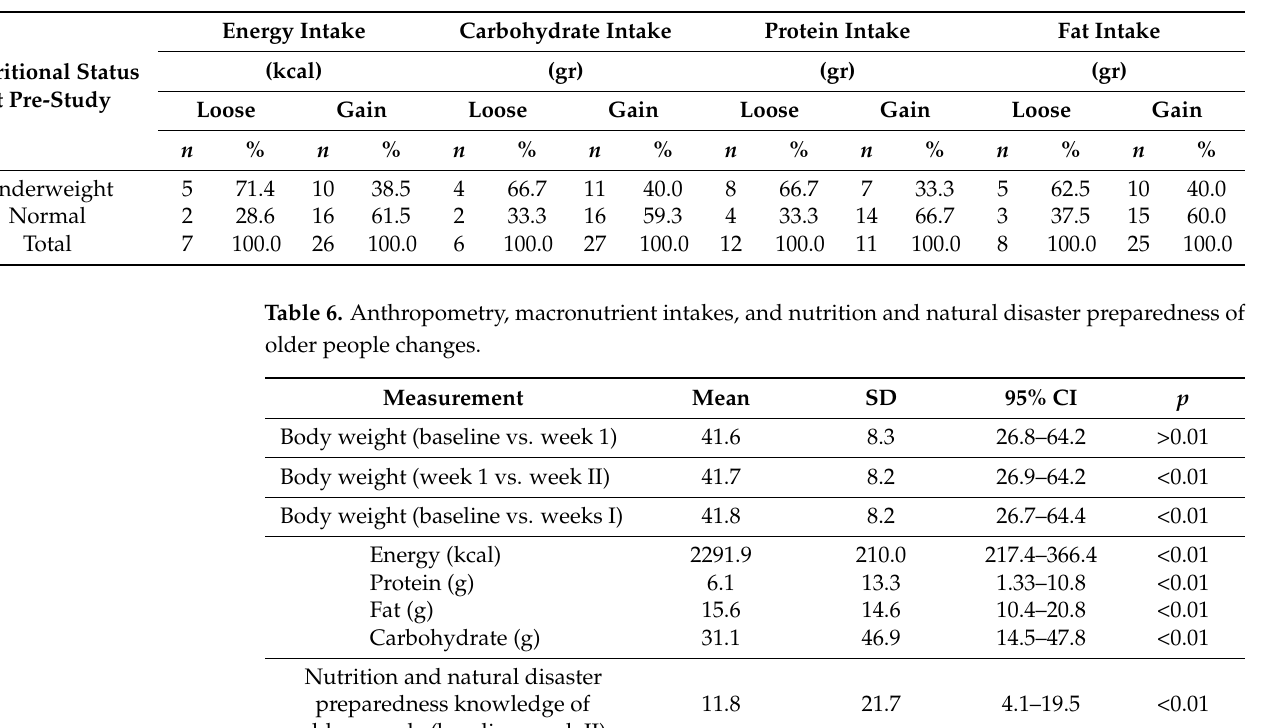
Table 5. Change of macronutrient intakes at pre-post study.